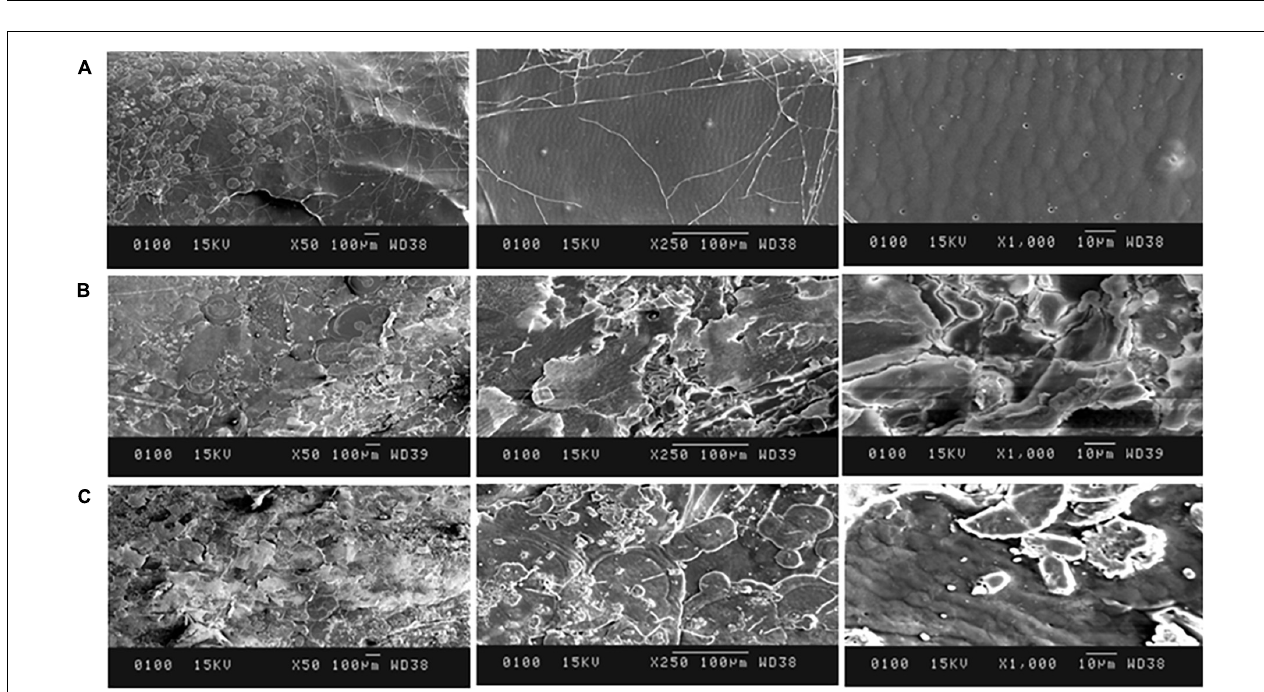
FIGURE 10 | SEM images of shrimp shells (A) before treatment, (B) PyCP, and (C)